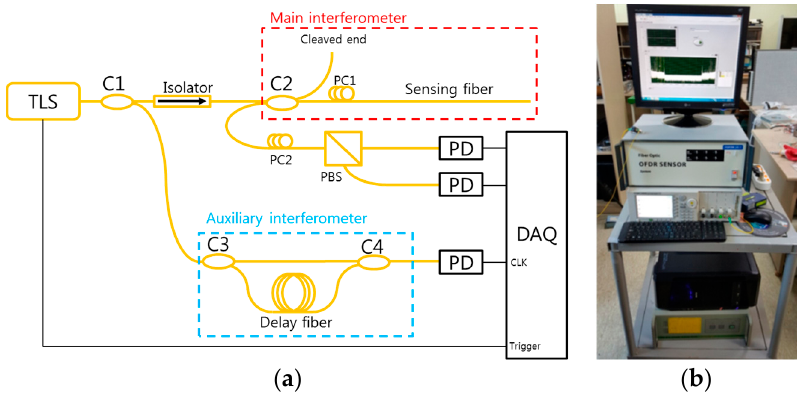
Figure 2. Fiber optic optical frequency domain reflectometry (OFDR) sensor. ( a ) Schematic diagram ( b ) Fabricated OFDR. (TLS: tunable laser source, PD: Photo-detector, DAQ: data acquisition, CLK; Clock)